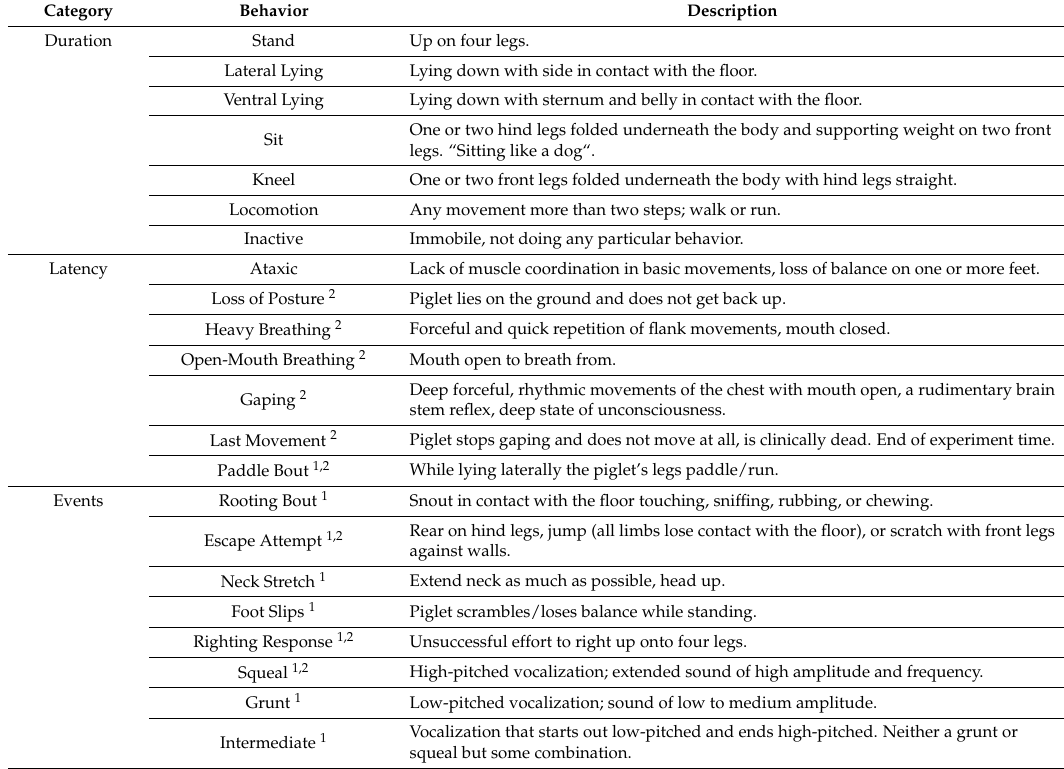
Table 1. Ethogram of piglet’s behavior during euthanasia for Experiments 1 and 2. Behavioral recordings started from the time the two straps of the box were latched. Interruptions shorter than 3 s are considered the same bout of